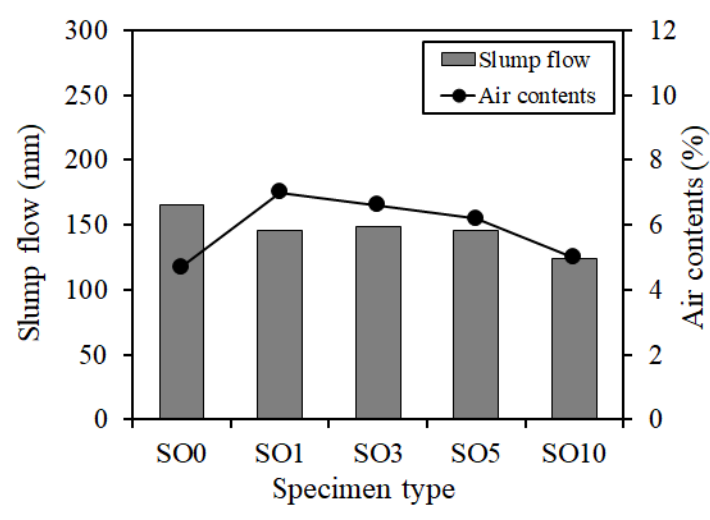
Figure 3. Fresh properties.